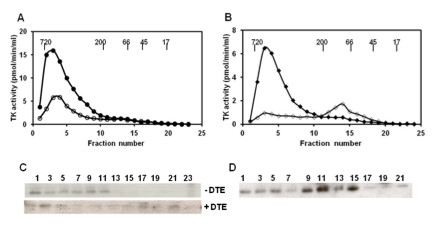
Quaternary structures of serum TK1. (A) Thymidine kinase activity in serum fractions from dogs with acute lymphocytic leukemia (●) injected directly into the Superose 12 column, or pre-treated with 20 mM DTE (○). (B) Thymidine kinase activity in serum fractions from human patients with acute lymphocytic leukemia (♦) injected directly into Superose 12 or pre-treated with DTE (◊). Arrows indicate the elution position of molecular weight markers. (C) Western blot analyses of untreated dog serum samples (−DTE) or those pre-treated with 20 mM DTE (+DTE), using polyclonal anti-dog TK1 antibody. (D) Western blot analyses of untreated human serum samples (−DTE) or those pre-treated with DTE (+DTE), using monoclonal anti-human TK1 antibody. The numbers represent FPLC fractions.